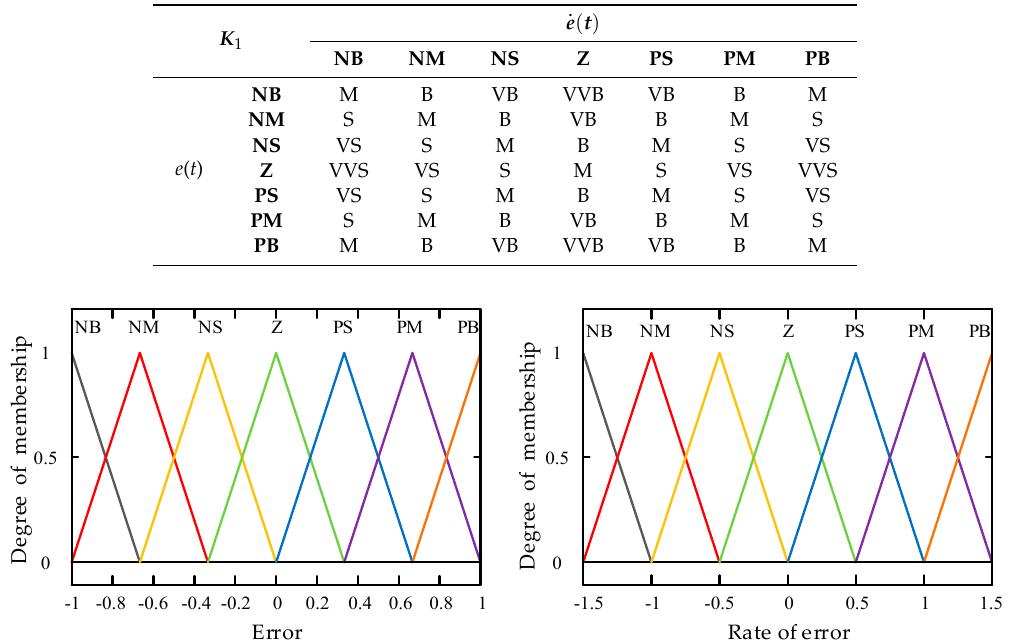
Table 1. Rules table of the fuzzy logic system.